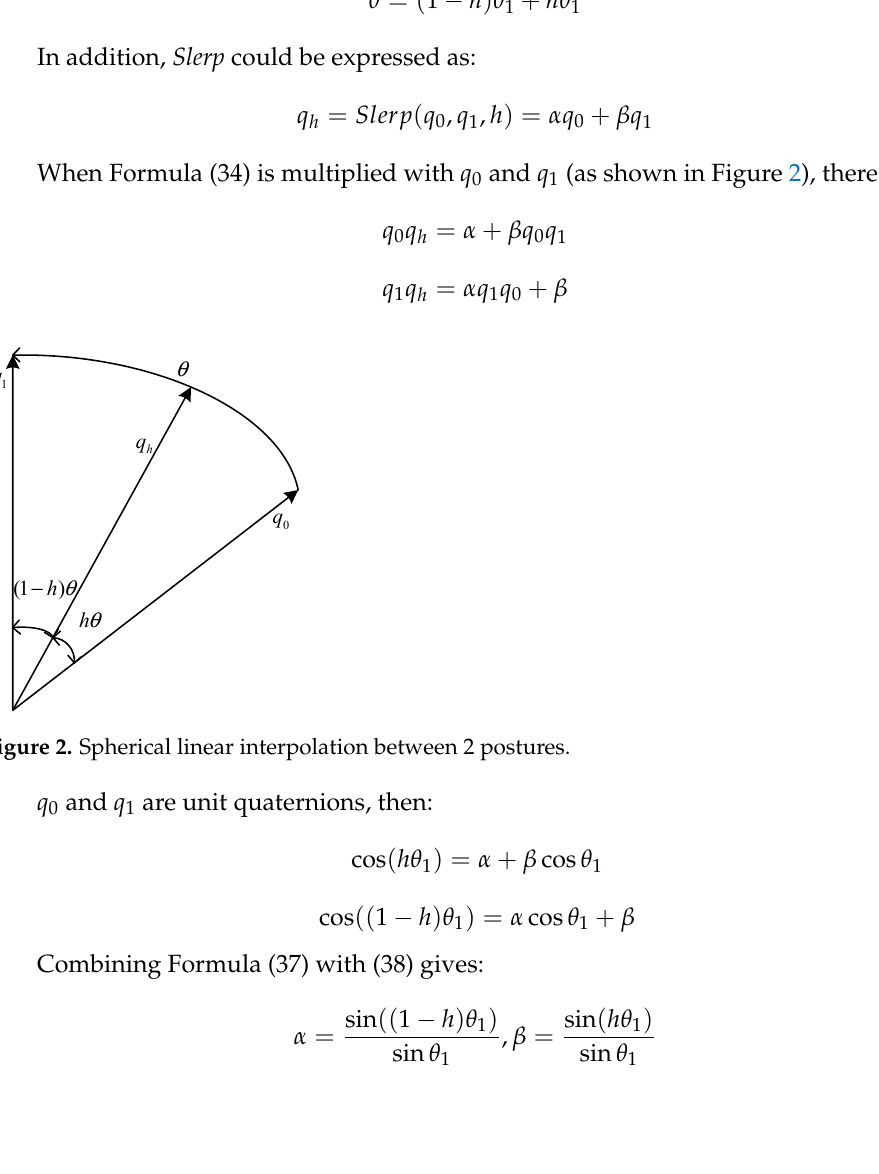
Figure 1. Linear interpolation between 2 postures. q 0 and q 1 are unit quaternions, then: In the above interpolation algorithm, when h is uniformly distributed within the interval [0, 1], the interpolation segments obtained are not uniformly distributed, i.e., linear interpolation only has formally "linear interpolation". Slerp , i.e., spherical linear interpolation, which is linear interpolation on the sphere, which is a linear interpolation of angles, i.e.,